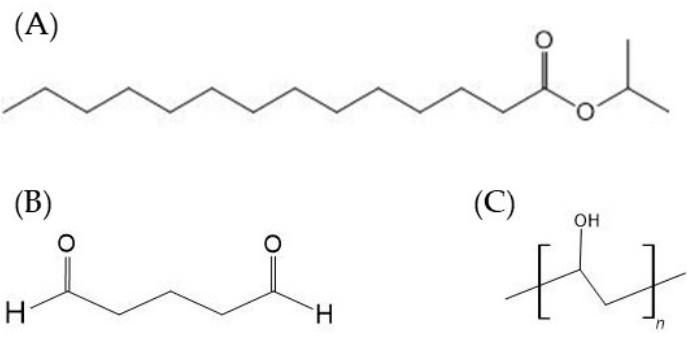
Figure 5. Chemical structure of ( A ) Isopropyl myristate, ( B ) glutaraldehyde, and ( C ) polyvinyl